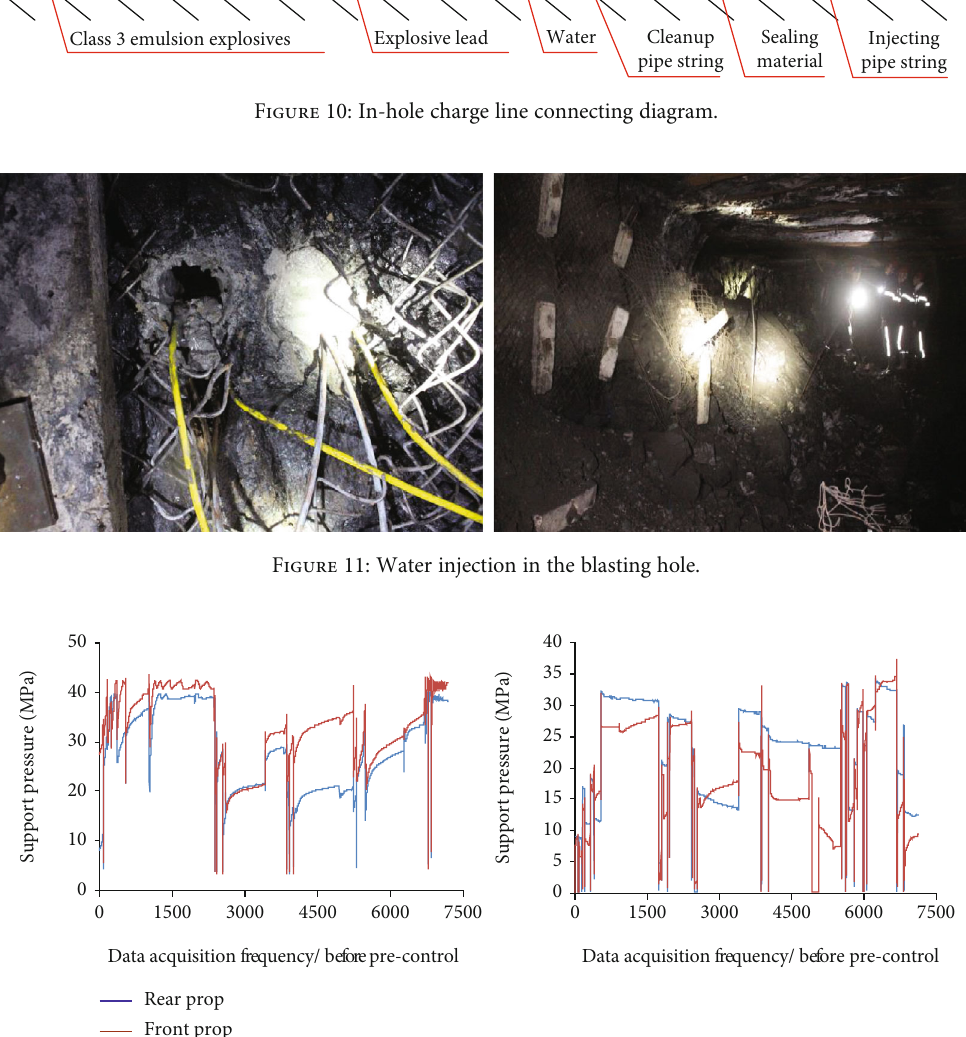
Figure 12: Support pressure of the working face before and after roof